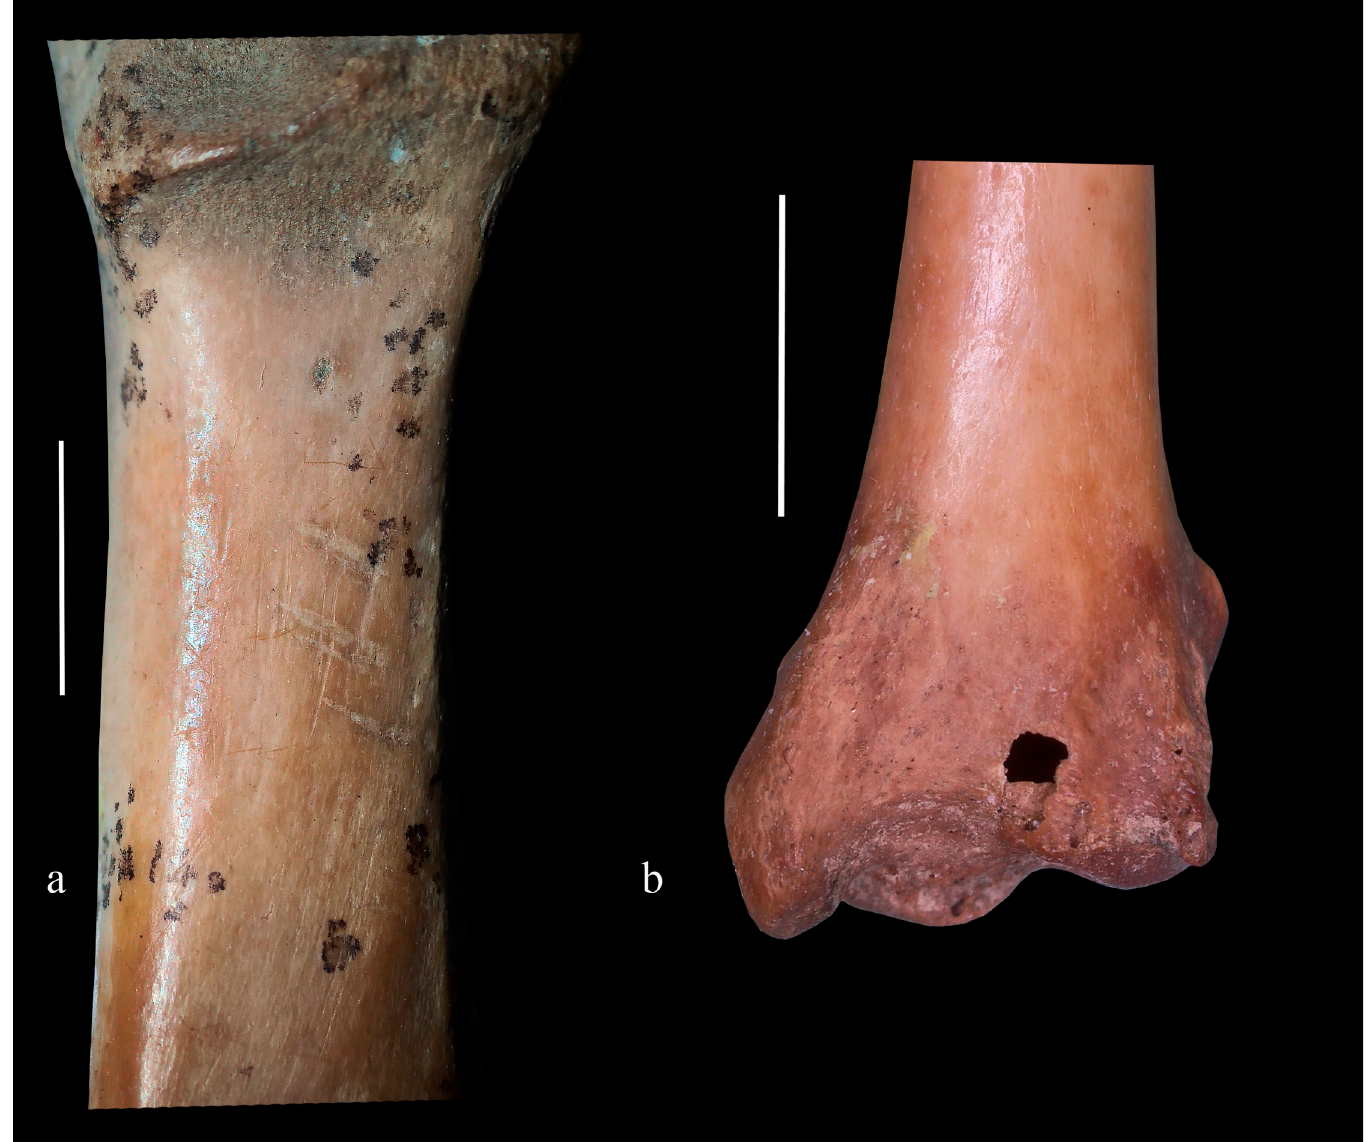
Fig 4. Human-caused modifications (arrows) on avian bones from Istykskaya cave. a , cut-marks on the dorsal surface of coracoid of A . fuligula , specimen IST 2019-3- 69; b, humerus of Gallinula chloropus (specimen IST 2019-2-49), showing characteristic notch on the caudal surface of the fossa olecrani, made by overextending the joint to disarticulate the